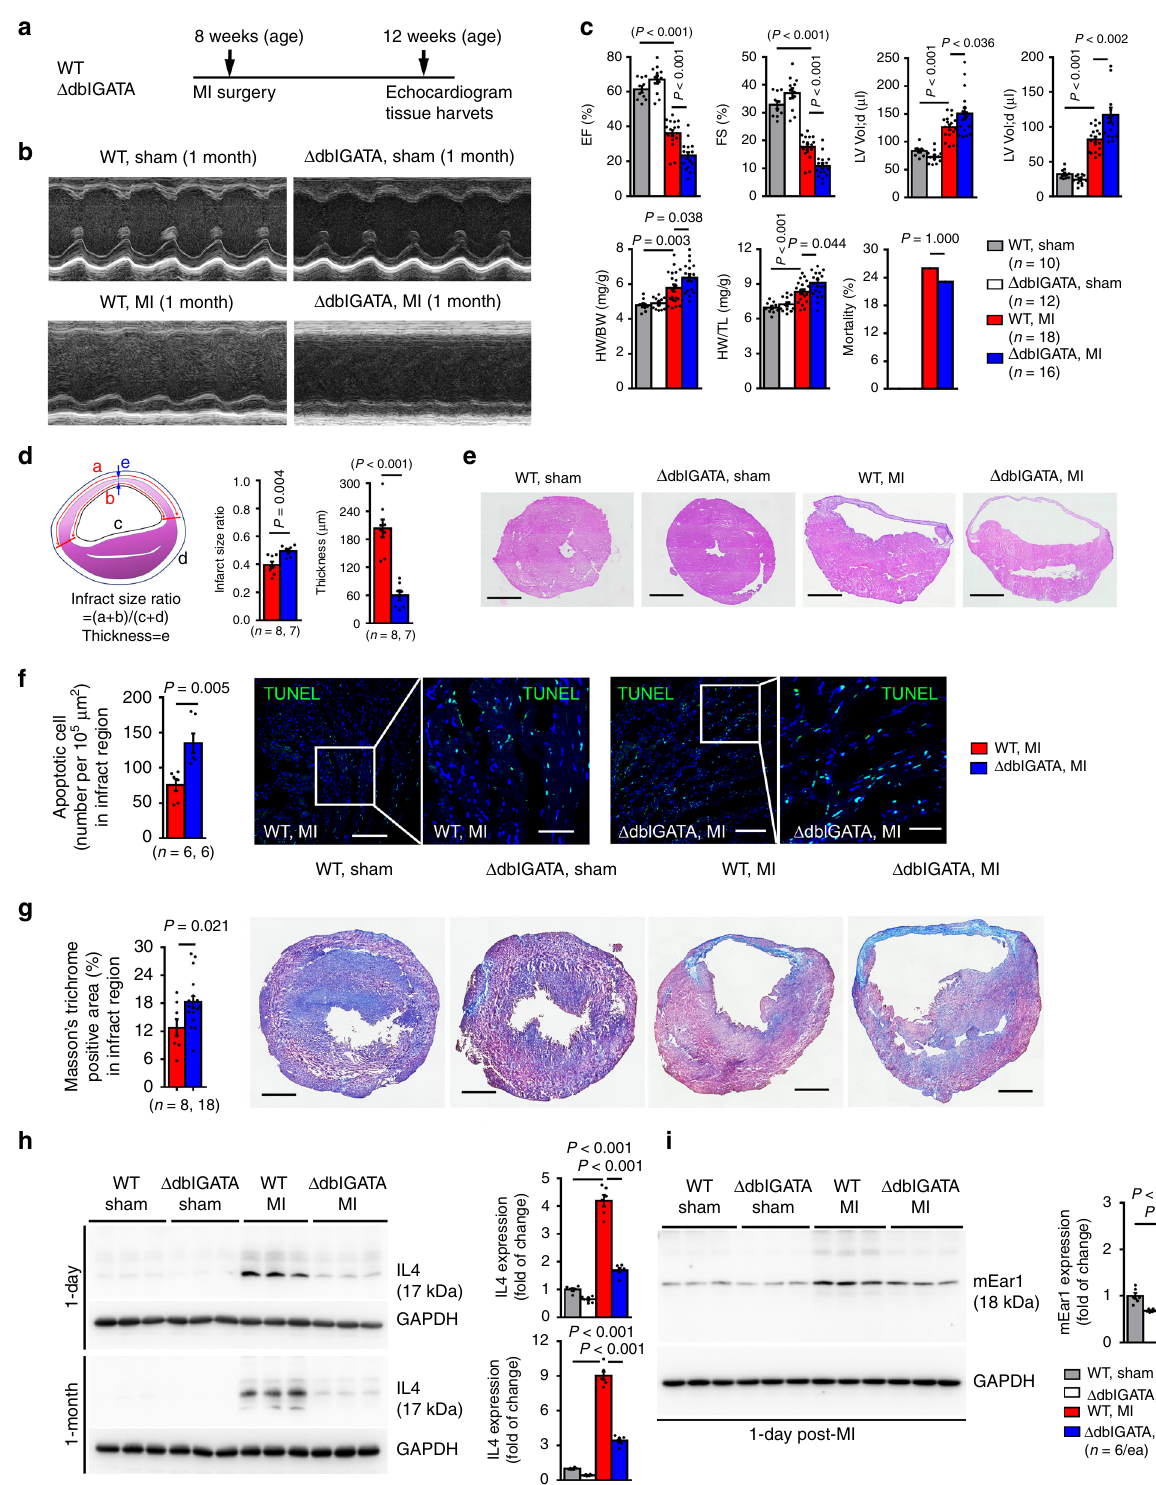
Fig. 2 EOS-de fi ciency exacerbates cardiac dysfunction post-MI. a Mouse surgery strategy. b Representative LV M-mode echocardiography images from WT and Δ dblGATA mice at 1-month post-MI or sham. c Cardiac functions at 1-month post-MI: EF, FS, LV Vol;d, LV Vol;s, HW/BW ratio, HW/TL ratio, and mortality rate in different groups of mice as indicated. d Infarct size ratio, infarct thickness, and calculating formulas. e H&E staining for d Scale: 1500 µ m. f TUNEL-positive apoptotic cells in infarct region. Scale: 100 µ m, inset: 40 µ m. g Masson ’ s trichrome staining determined collagen deposition in the infarct region. Scale: 1500 µ m. Representative images in f and g are shown to the right. h , i . Immunoblots detected IL4 ( h ) and mEar1 ( i ) expression in heart from WT and Δ dblGATA sham and MI mice at 1-day and 1-month post-MI. Data are mean ± SEM. The numbers mice of in each experimental group and P values are indicated ( c , d , f – i ), one-way ANOVA test ( c , h , i ) and non-parametric Mann-Whitney U test ( d , f , g